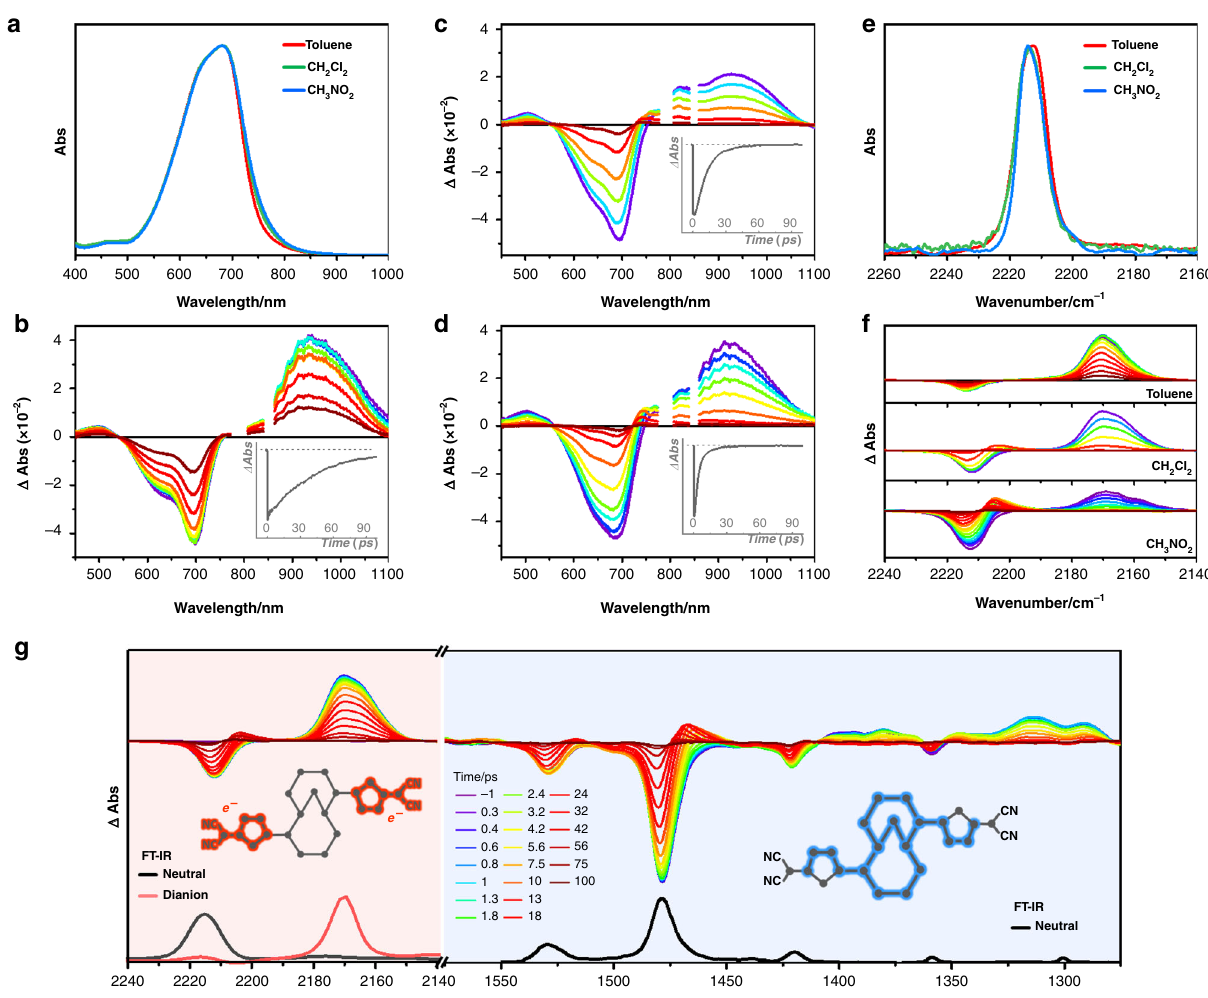
Fig. 2 Electronic and vibrational spectra of TMTQ. a – d The steady-state ( a ) and transient absorption spectra of TMTQ in toluene ( b ), CH 2 Cl 2 ( c ), and CH 3 NO 2 ( d ). The inset plots are the decay pro fi les at 660 nm. e , f The FT-IR ( e ) and transient IR ( f ) spectra of TMTQ in toluene, CH 2 Cl 2 , and CH 3 NO 2 . The transient IR spectra were plotted within ~100 ps time window (from purple to dark red colored lines). g The transient IR spectra of TMTQ in CH 2 Cl 2 . The spectra in the regions of 2140 – 2240 and 1275 – 1575 cm − 1 are assigned to IR bands for C ≡ N and C = C stretching vibrations, respectively. The FT-IR spectra of neutral and electrochemically produced dianion TMTQ are